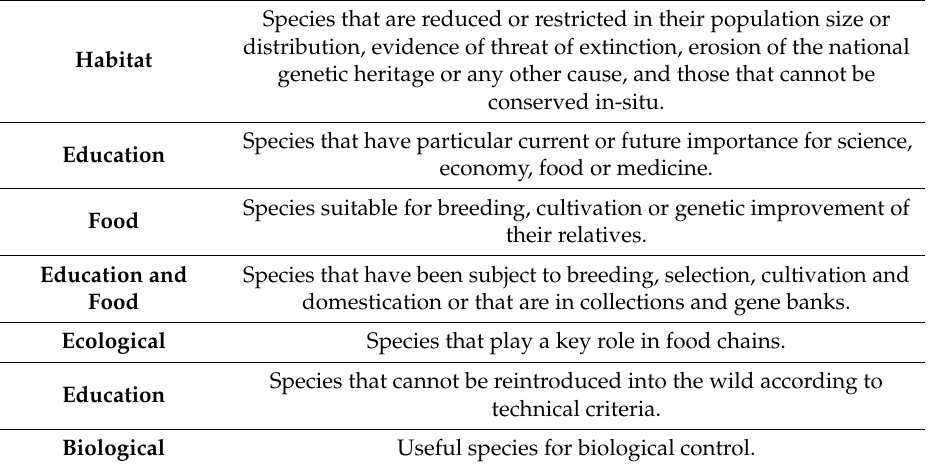
Table 5. Conditions for ex-situ conservation processes.